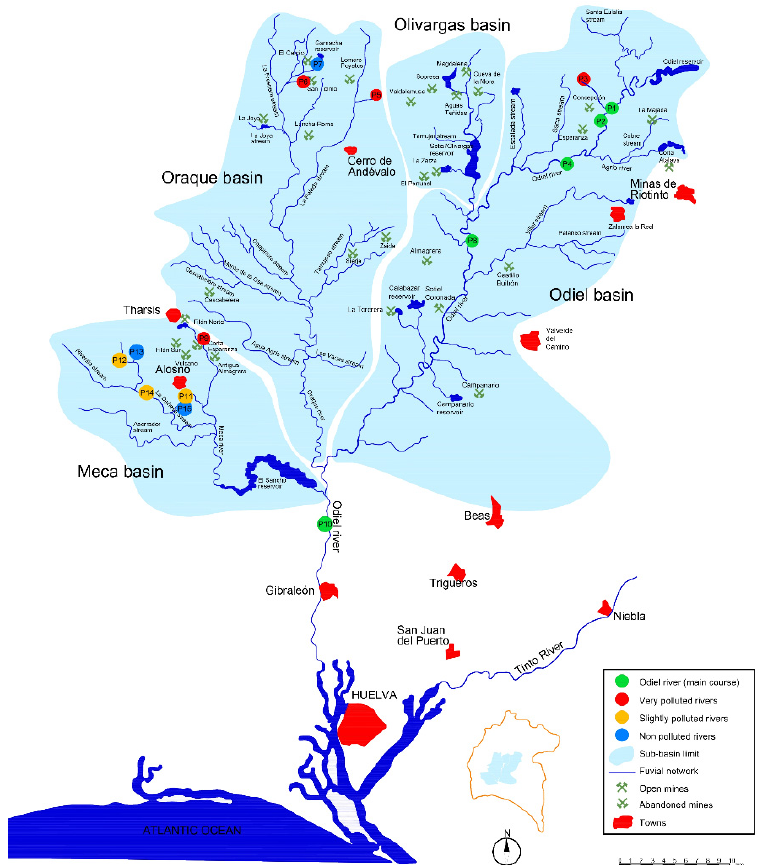
Figure 2. Map of the fluvial network with the sampling points’ location. The main channel corresponds to points 1, 2, 8, 10 and appears in green. Point 1 corresponds to Odiel before being contaminated and 10, the last one, before the tidal influence; the remaining points 2, 4, 8 correspond to downstream points. The rest of the sampling points are not in the same stream. They go from zero contamination degree: regional background= point 7 and points 13 and 15, also unaffected sites. The remaining points with color code orange and red were colored regarding their increasing contamination degree, slightly to very polluted sites, respectively.